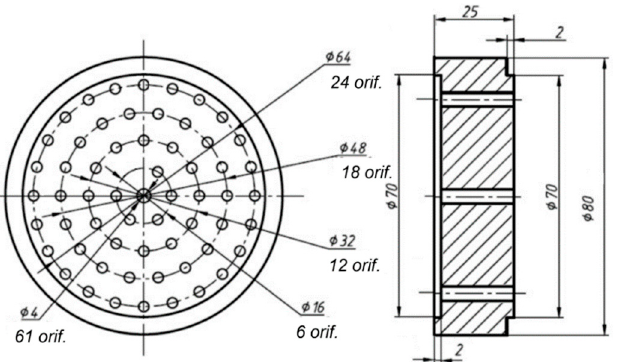
Figure 3. One of 16 identical polyethylene blocks for assembling a test sample; dimensions are given in millimeters.